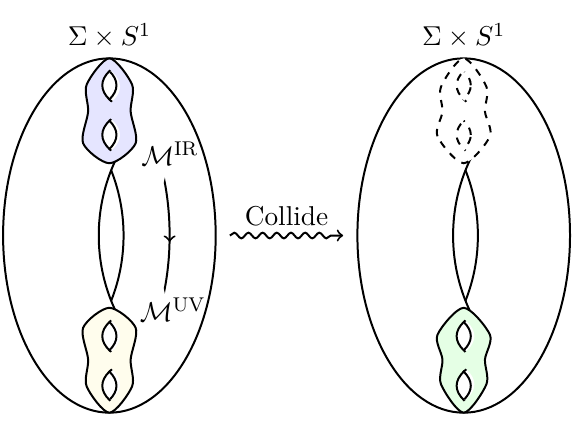
Figure 15 . Deforming the WZW models by a relevant operator and flowing to the IR, we are left with two topological interfaces in a 3d Chern-Simons bulk on Σ × S 1 . If we let the two interfaces collide and then trace, we obtain the partition function of the relevant 2d TFT up to local curvature